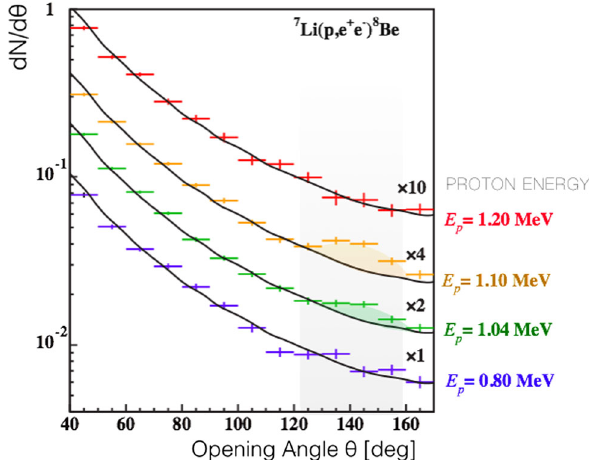
Fig. 28 TheATOMKIexcessatopeningangle θ e + e − ≈ 140 ◦ observed in the reaction p 7 Li → 8 Be e + e − [1]. The different colors show the spectrum as one scans through resonance by varying the proton beam energy, as indicated. From Ref.